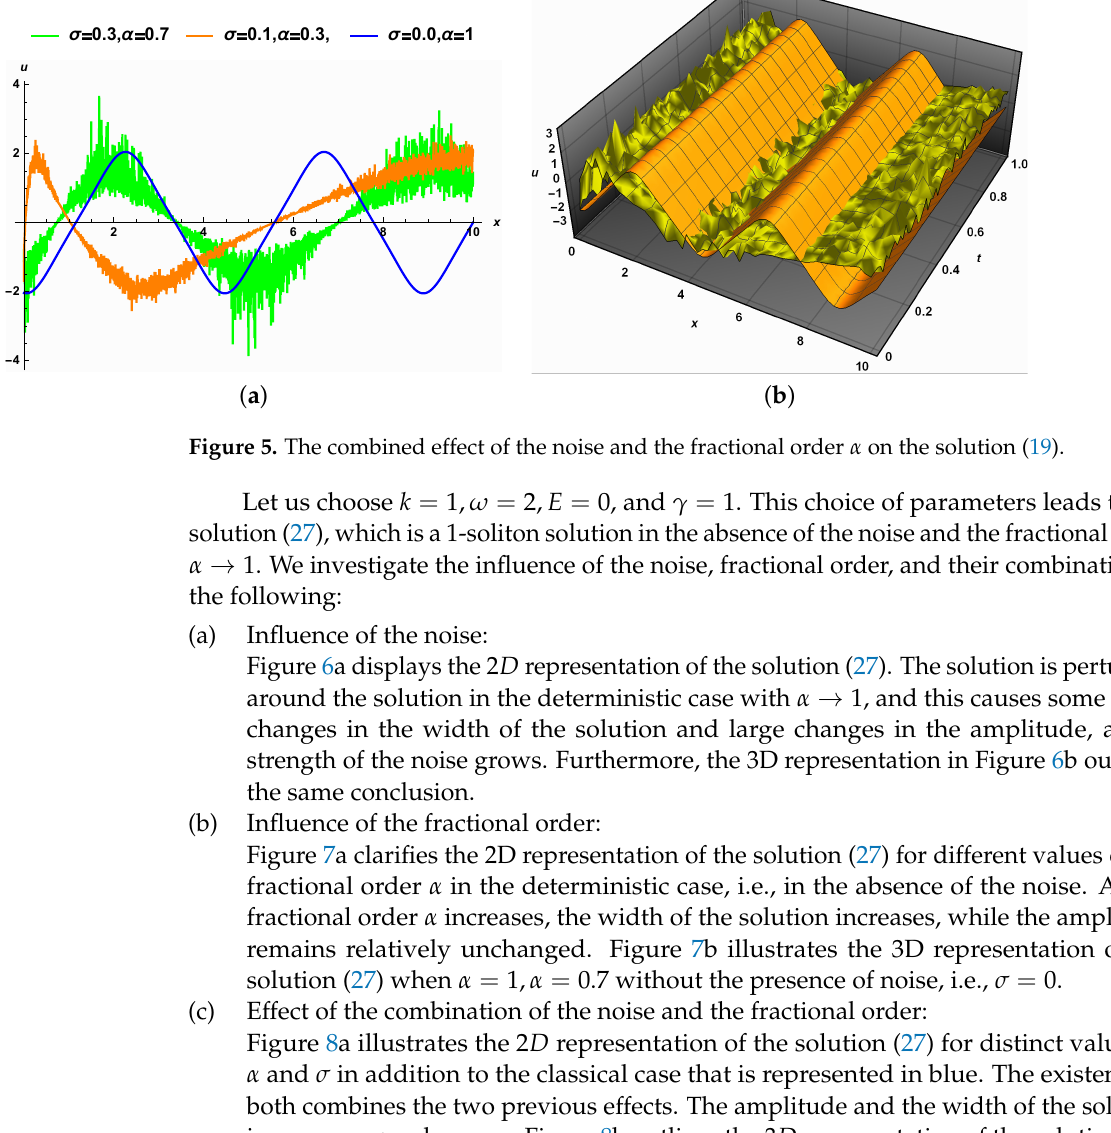
Figure 7a clarifies the 2D representation of the solution (27) for different values of the fractional order α in the deterministic case, i.e., in the absence of the noise. As the fractional order α increases, the width of the solution increases, while the amplitude remains relatively unchanged. Figure 7b illustrates the 3D representation of the solution (27) when α = 1, α = 0.7 without the presence of noise, i.e., σ = 0. Effect of the combination of the noise and the fractional